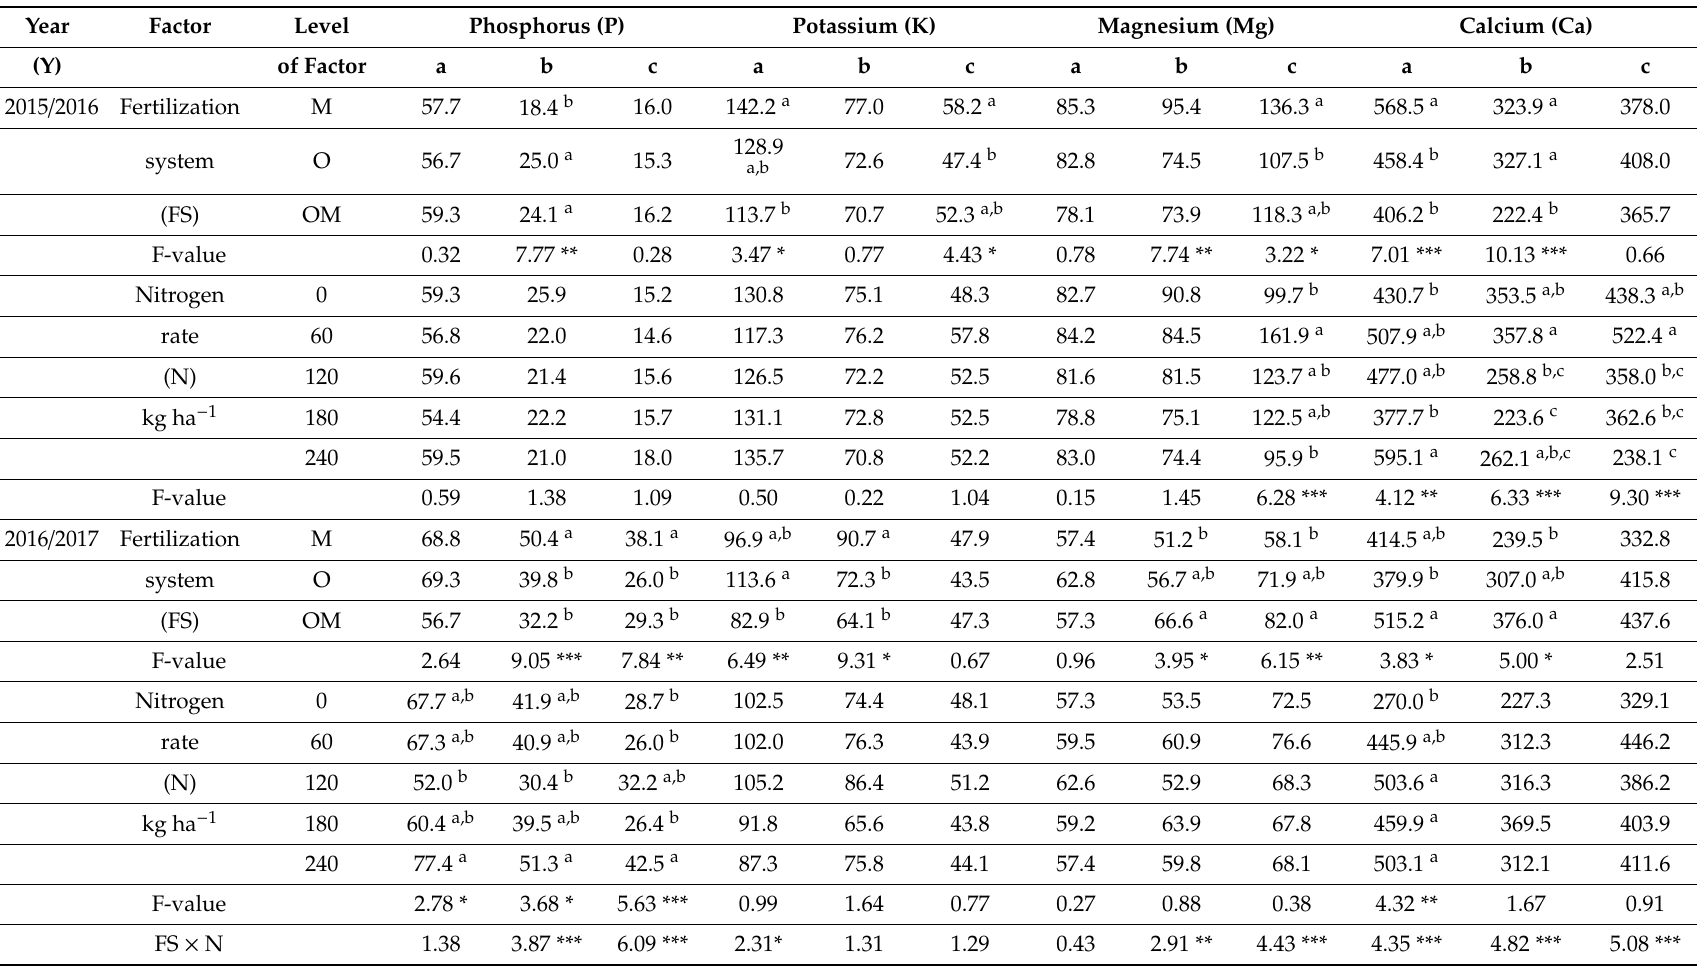
Table 5. The content of available nutrients along the soil layers at the onset of winter oilseed rape flowering (BBCH 60), mg kg − 1